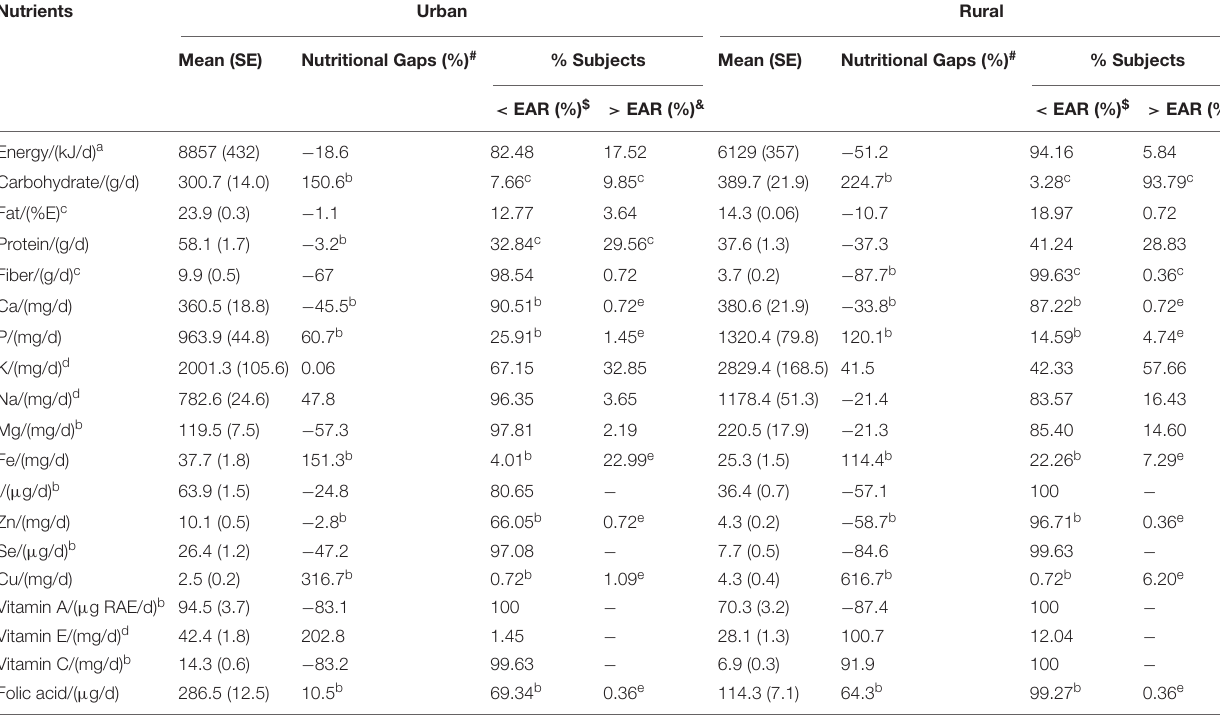
TABLE 5 | Nutrient gaps and prevalence of inadequate and excessive intake of nutrients by region. Nutrients Urban